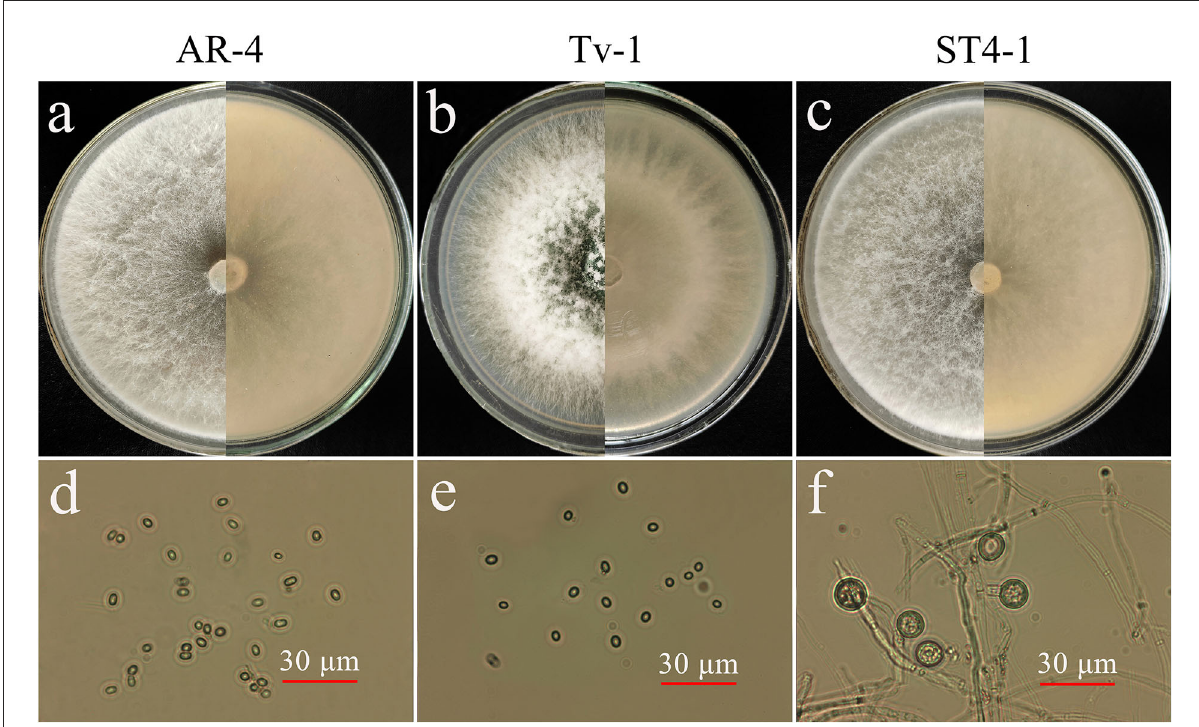
FIGURE4 Morphological characteristics of antagonistic Trichoderma spp. (a) Colony morphology of AR-4 (5d); (b) colony morphology of Tv-1 (5d); (c) colony morphology of ST4-1 (5d); (d) conidia of AR-4; (e) conidia of Tv-1; (f) chlamydospores of